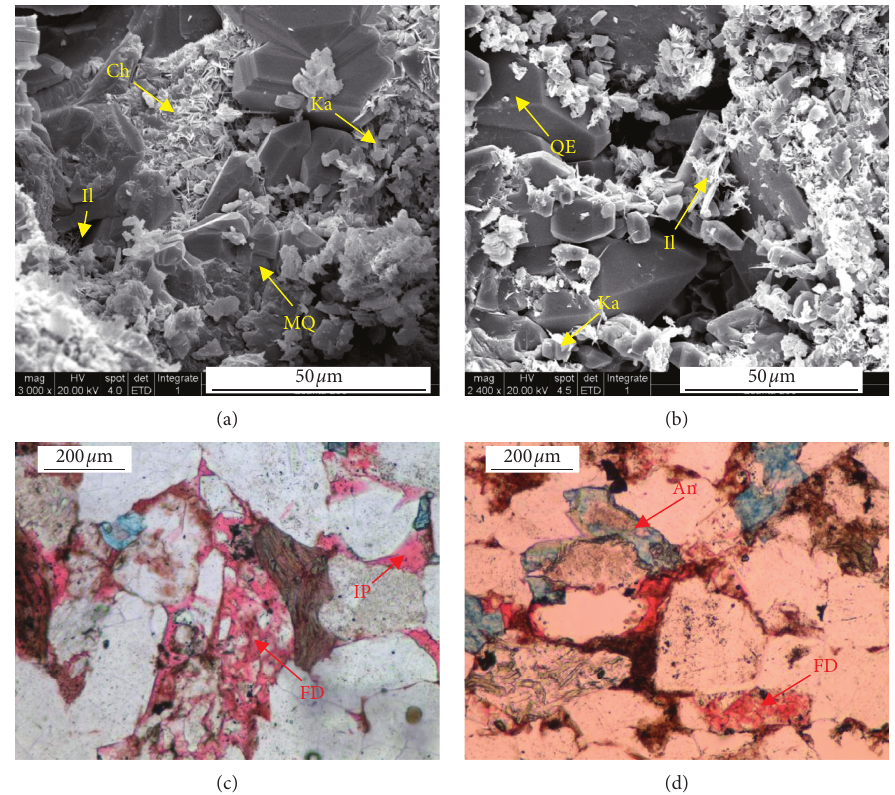
Figure 3: Diagenesis of Chang 2 reservoir in the study area. (a) Cementation of microcrystalline quartz (MQ), kaolinite (Ka), illite (Il), and chlorite (Ch) (N39, 1218.6m); (b) quartz enlargement (QE), intergranular kaolinite (Ka), and illite cementation (Il) (Z140, 1473.9m); (c) feldspar dissolution (FD) and intergranular pores (IP) (N9, 1210m); (d) ankerite (An) and feldspar dissolution (FD) (Z140, 1473.9m).